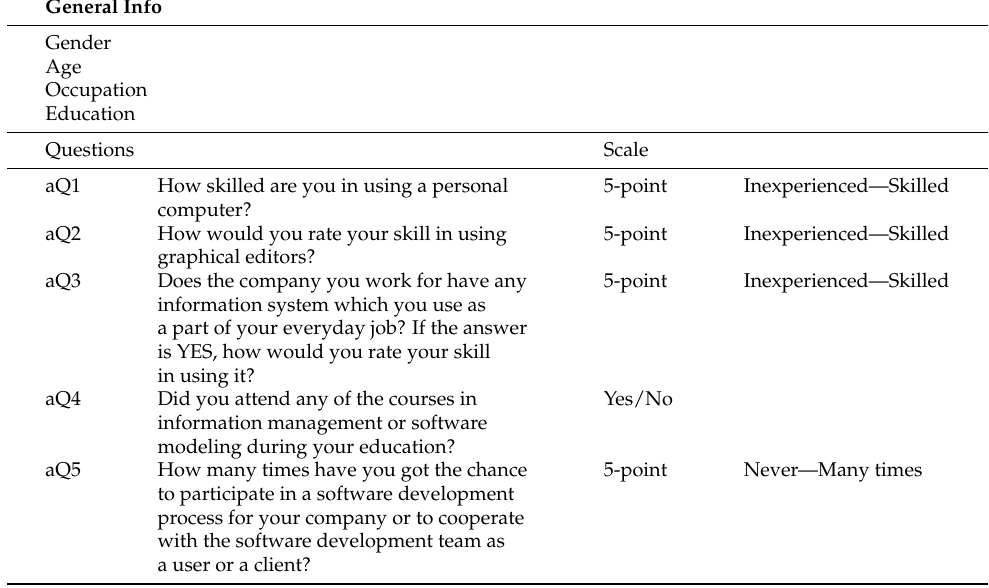
Table 1. Background questionnaire.